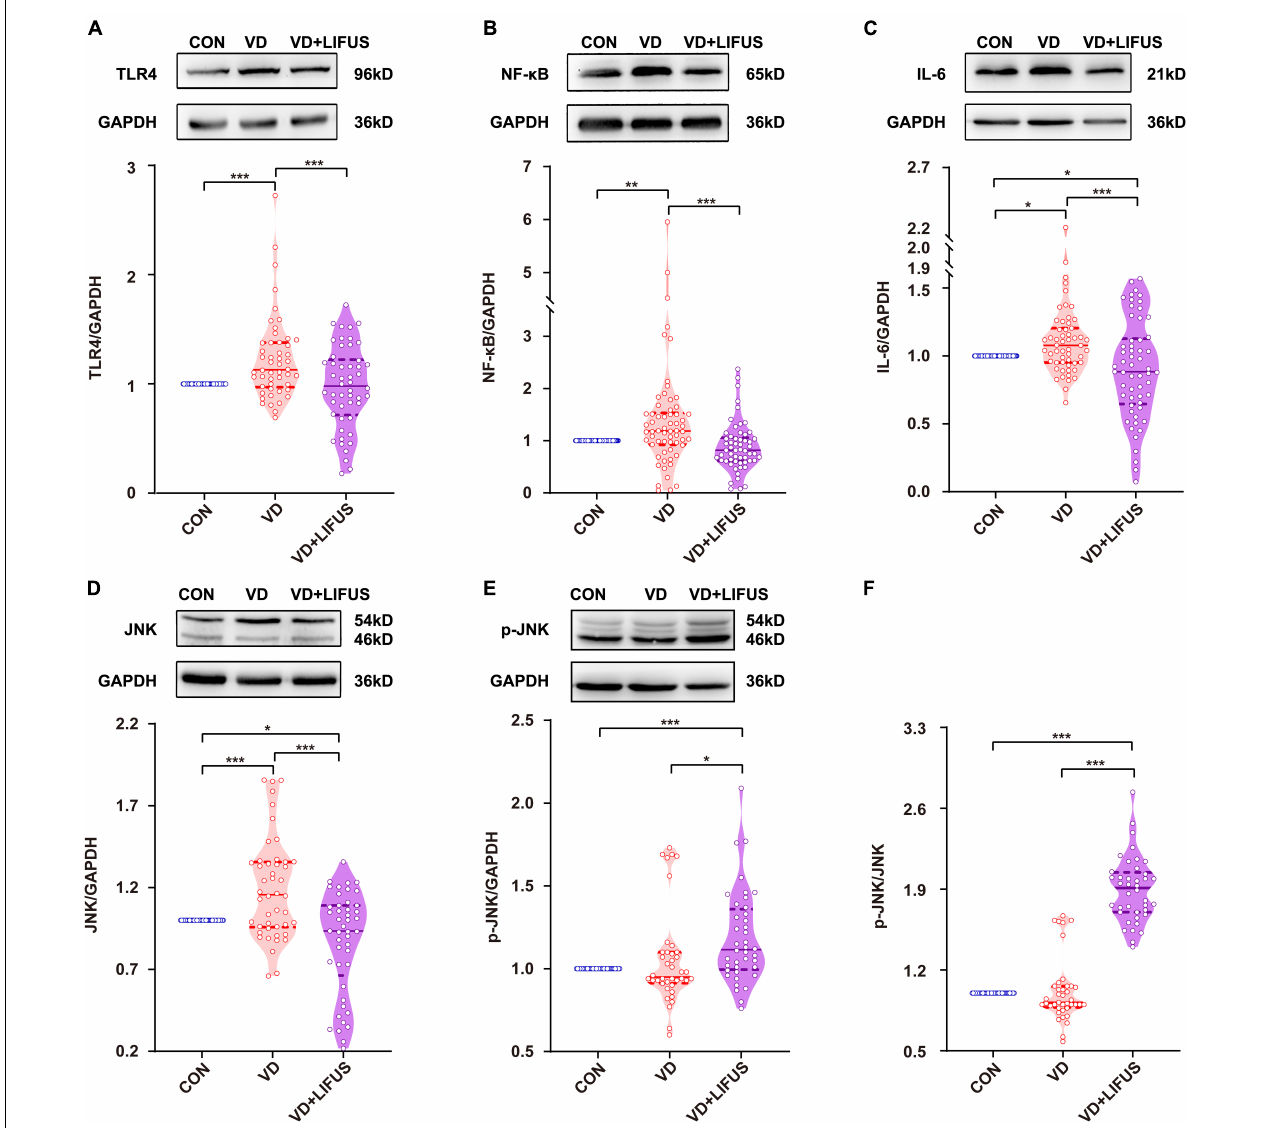
FIGURE 7 | Effect of LIFUS on the expression of neuroinflammatory related proteins. (A–F) The expression of TLR4, NF- κ B, IL-6, JNK, p-JNK, and ratio of p-JNK/JNK. Data are expressed as mean ± SEM. * p < 0.05, ** p < 0.01, *** p < 0.001 (CON, n = 6; VD, n = 4; VD + LIFUS, n =